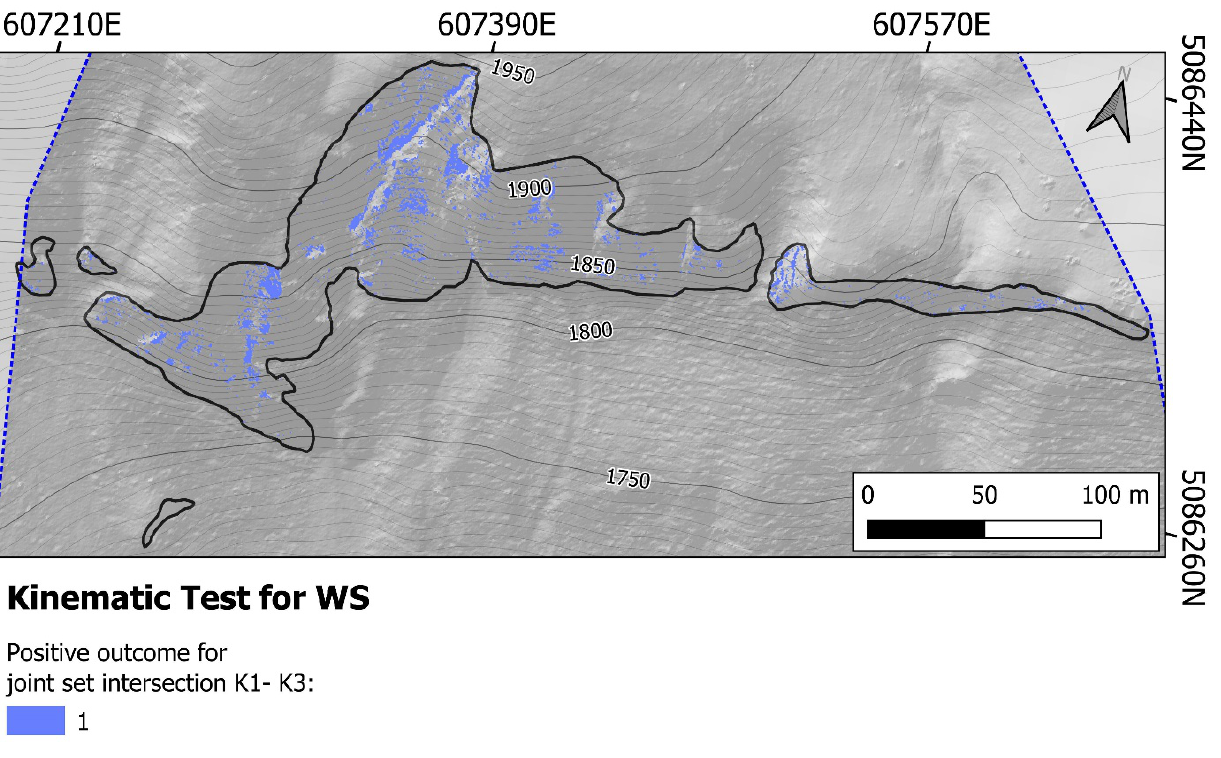
Figure A6. Image of the partial output file showing the kinematic test for WS performed considering only the intersection between joint set K1 and K3.